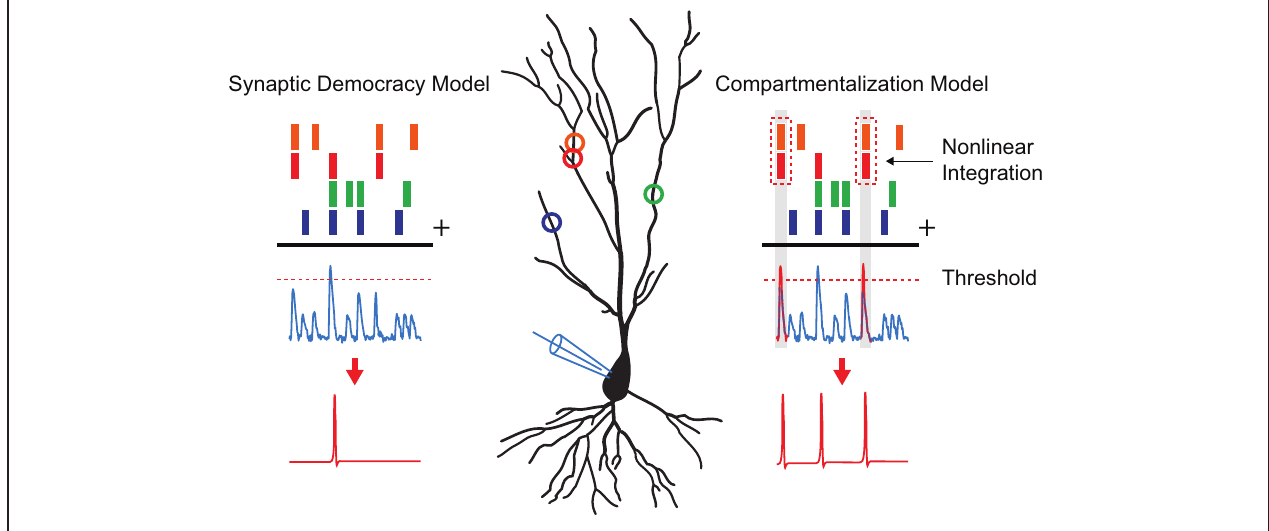
FIGURE 1 | Models of dendritic integration. A pyramidal neuron is depicted with synaptic inputs, represented as colored circles, making distributed contacts along its dendrite. The process of dendritic integration according to the “synaptic democracy” and the “compartmentalization” model are shown. Time points of synaptic input events are represented by the colored bars on top. The blue traces underneath show excitatory postsynaptic potentials as one would record in current clamp. When synaptic inputs reach